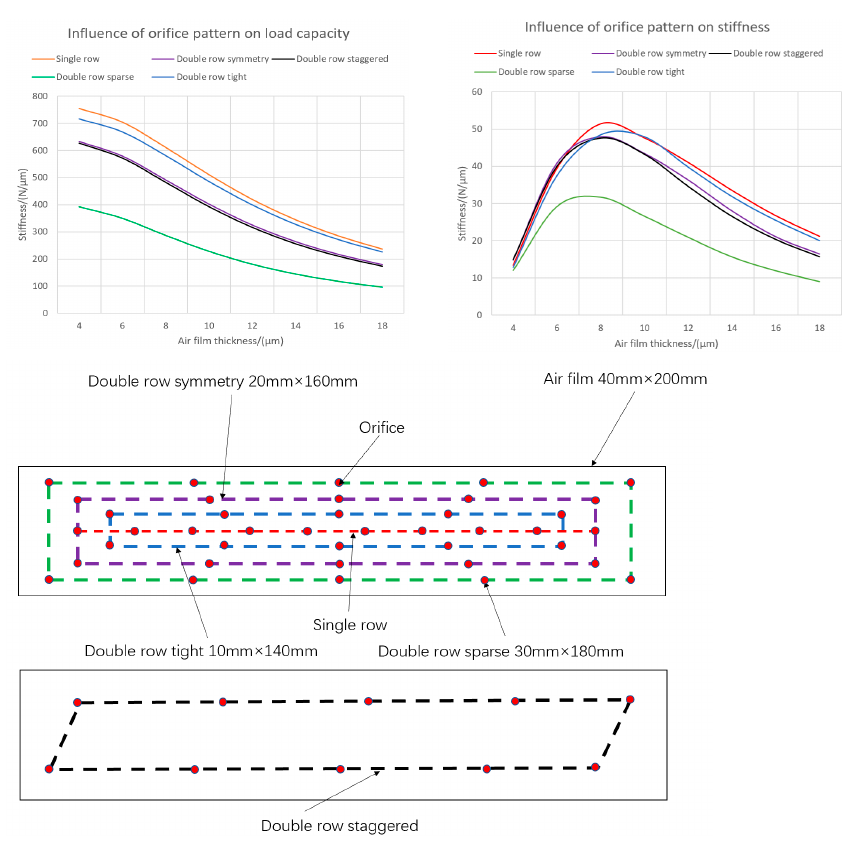
Figure 10. Load capacity and stiffness under different orifice patterns.